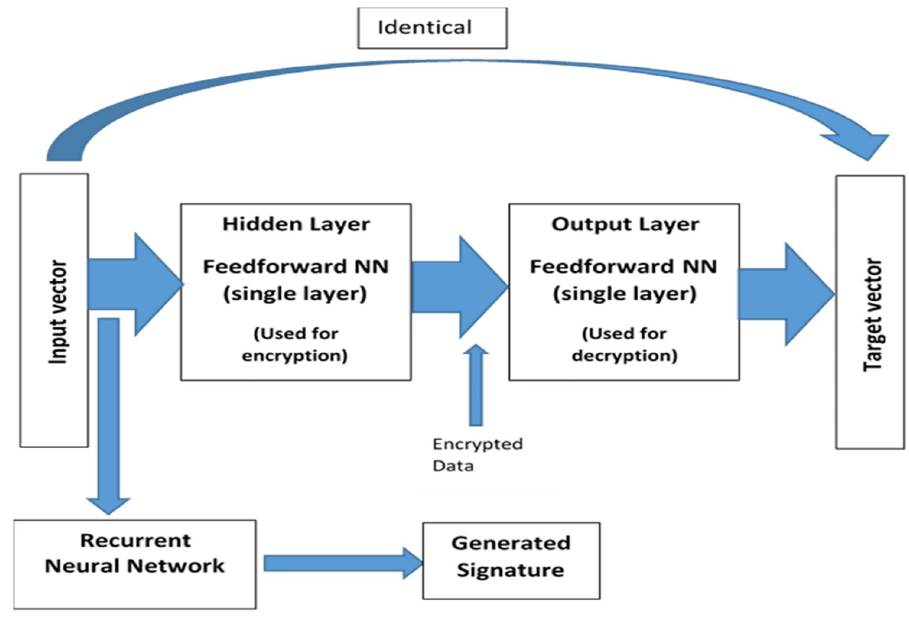
Fig 1. The mirror two-layered NN used for encryption/decryption and signature.